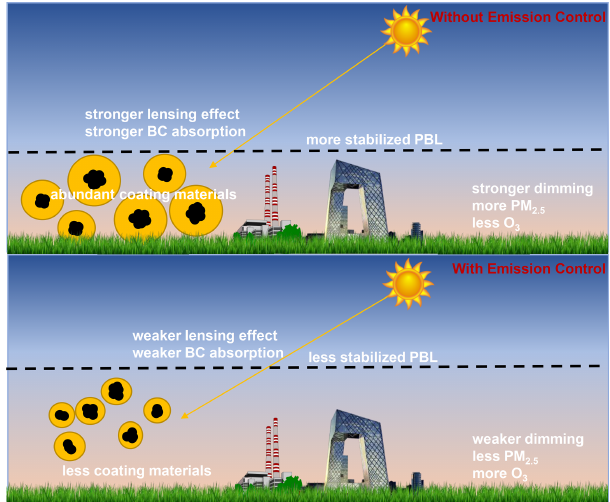
in vertical profiles of EPT. Different responses of PM 2 . 5 and O 3 were found to the changes in the light absorption of BC.